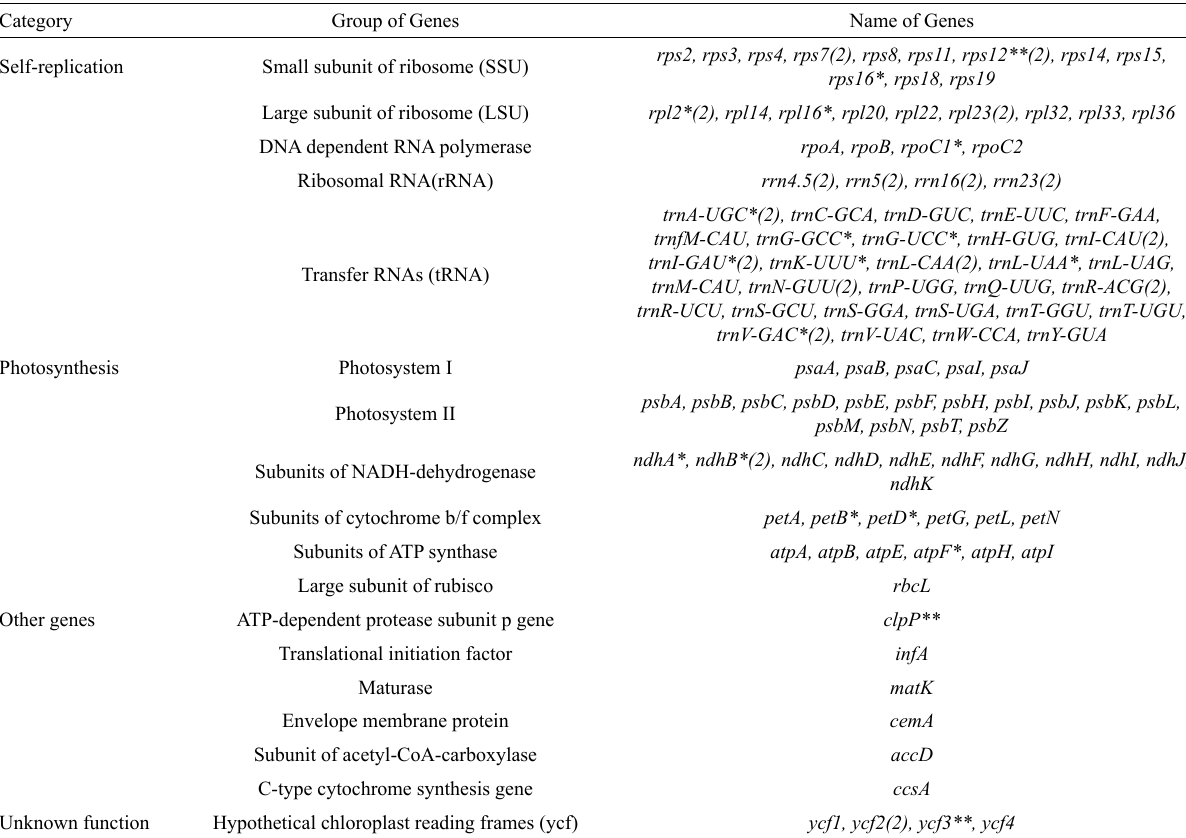
Table 1 – Genes present in the chloroplast genomes of Blumea balsamifera